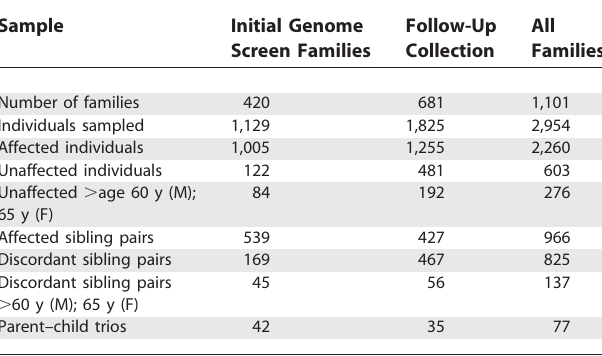
Table 2. GENECARD Sample